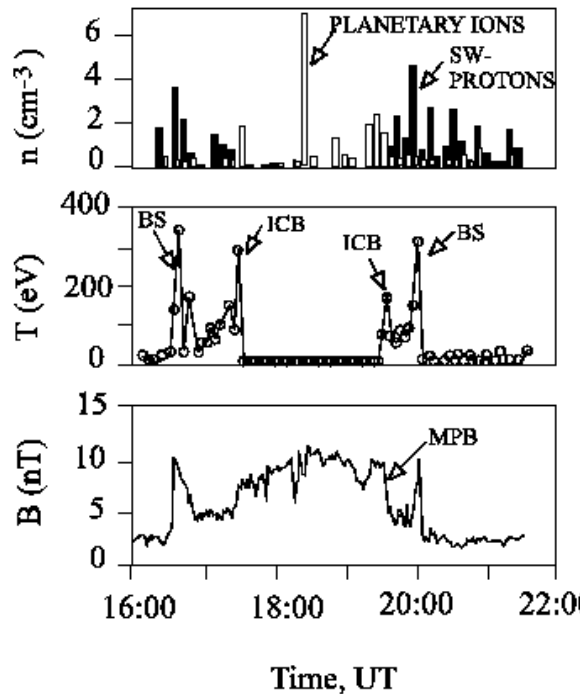
Fig. 1. Number density of the solar wind protons and heavy ions, proton temperature and magnetic field along a circular orbit from 16 March 1989 measured by ASPERA on board Phobos-2 (adapted from Sauer and Dubinin, 2000). In the plasma wake of the planet no solar wind protons are observed (proton cavity). The ion com- position boundary (ICB) separates the solar wind protons from the planetary ions in this orbit. The sharp decrease of the proton tem- perature shows a clear feature of this boundary. At the same position a magnetic pile-up boundary (MPB) can be